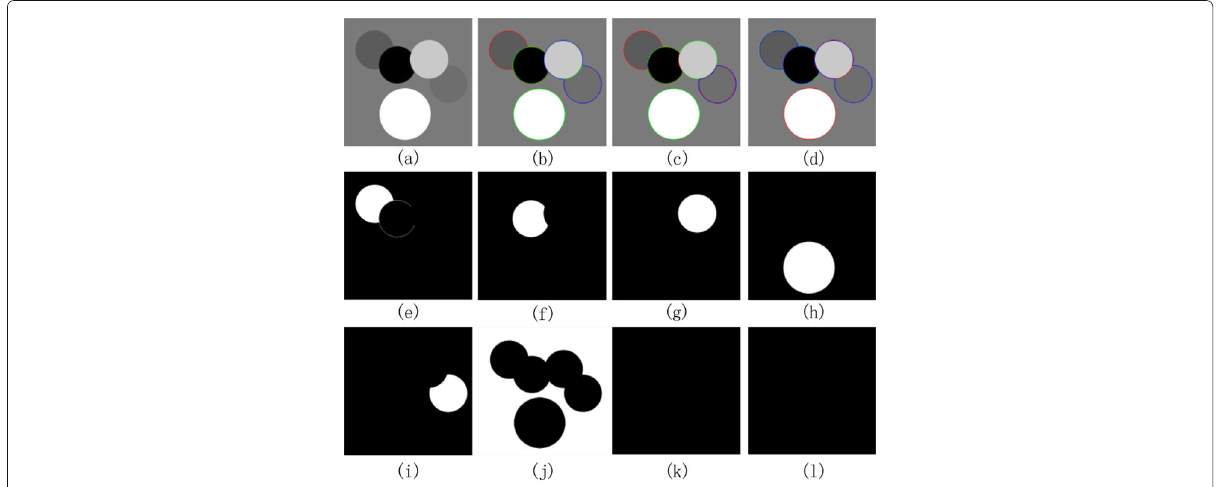
Fig. 7 Six-phase segmentation of original Vese-Chan method, TV regularization method and our method. a The input synthetic image. b The segmentation of original Vese-Chan method. c The segmentation of TV regularization method. d The segmentation of our method. e – l Different regions obtained via our method